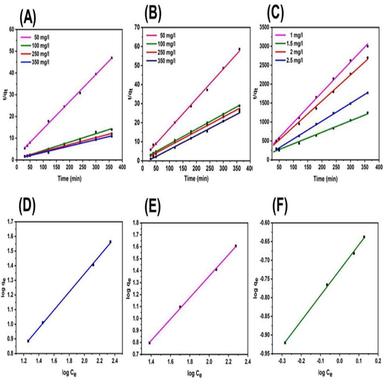
Kinetic study curves of Cu-ACC; PSO model for (A) Calcium, (B) Magnesium, (C) Fluoride and Isotherm curves for Cu-ACC of Freundlich model for (A) Calcium, (B) Magnesium, (C) Fluoride.